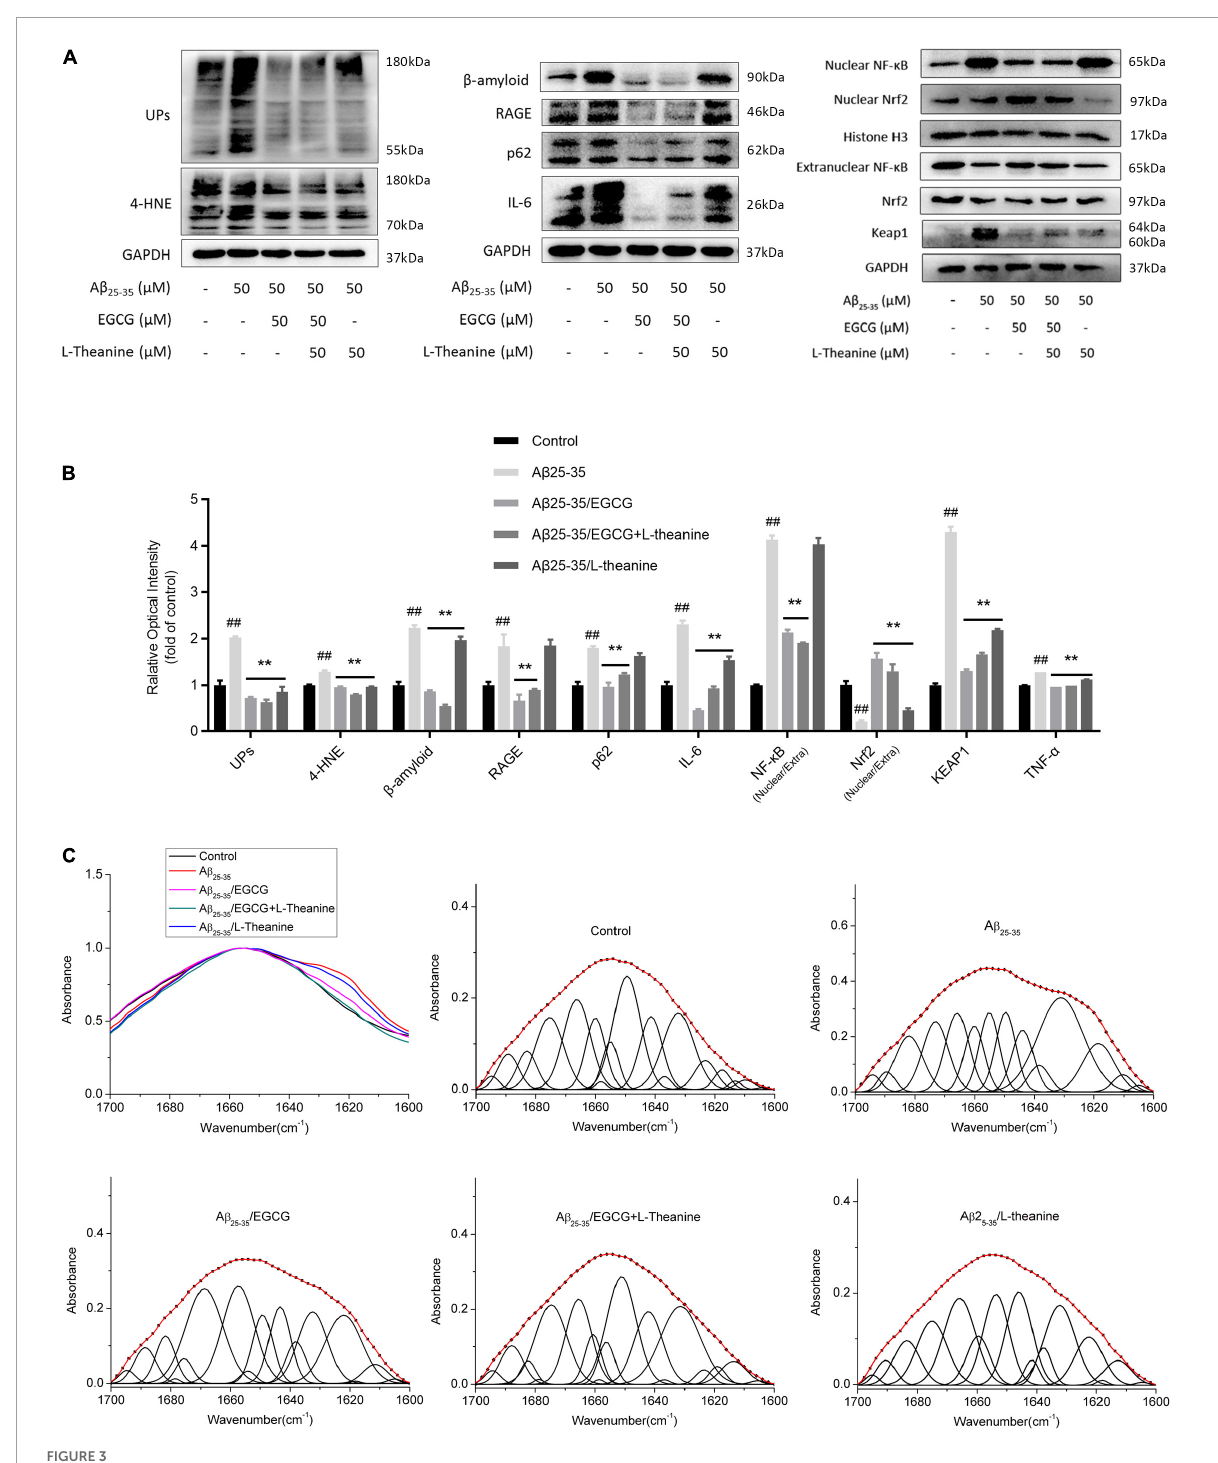
FIGURE3 EGCG and L -theanine synergistically inhibit amyloidogenic and inflammatory pathways. (A,B) ELISA and Western-blotting detection and analysis of protein expression levels associated with aggregates formation and inflammation. Among them, ELISA detected TNF- α , and Western-blotting detected the remaining proteins. “Nuclear/Extra” indicates the degree of nuclear translocation of the associated proteins. (C) Amide I band (1700–1600 cm − 1 ) infrared spectra and Gaussian fitting analysis of cell samples in different treatment groups. In the fitted plots, amide I maxima between 1675 and 1695 cm − 1 are generally assigned to antiparallel β -sheet/aggregated strands; and amide I maxima of 1660–1670 cm − 1 , 1648–1660 cm − 1 , 1640–1648 cm − 1 , 1625–1640 cm − 1 , and 1610–1628 cm − 1 are assigned to 3 10 -helix, α -helix, unordered strands, β -sheet, and aggregated strands, respectively (49). ## p < 0.01, compared with control group; ** p < 0.01, compared with A β 25 − 35 group, n =